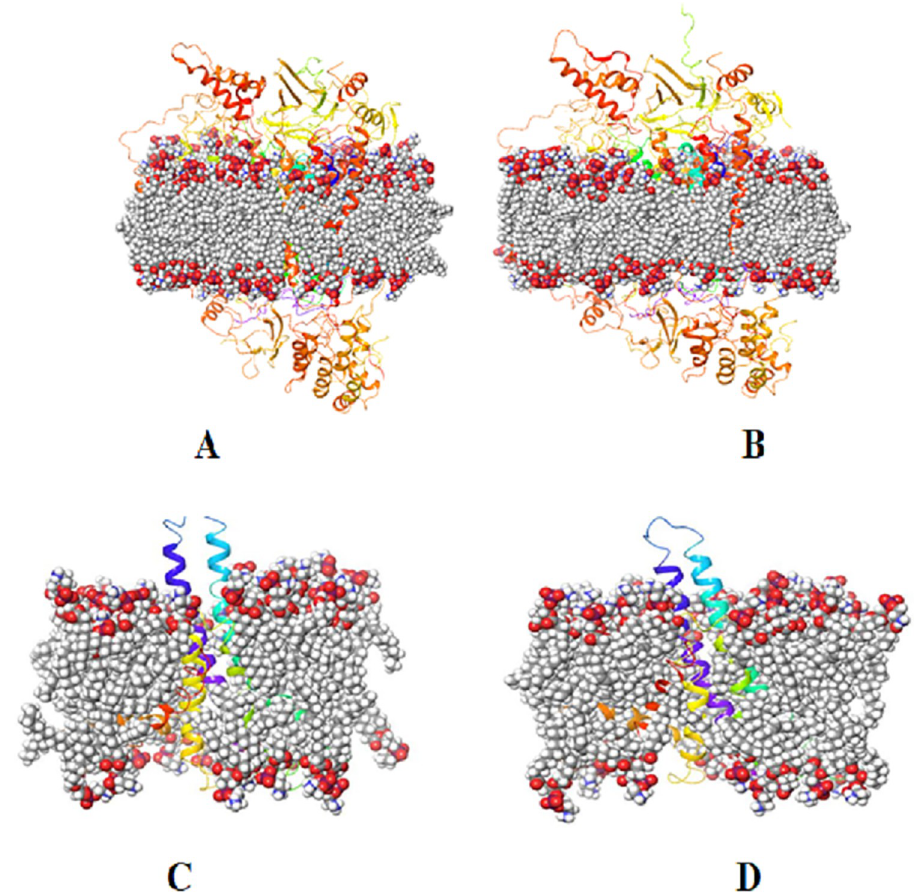
Fig 4. Conformations of 20 ns simulation of (A) wild type cytochrome C oxidase (B) G78S (C) wild type mitochondrial ATPase (D) T146A mutant proteins embedded in POPE membrane displaying closed and open conformations,